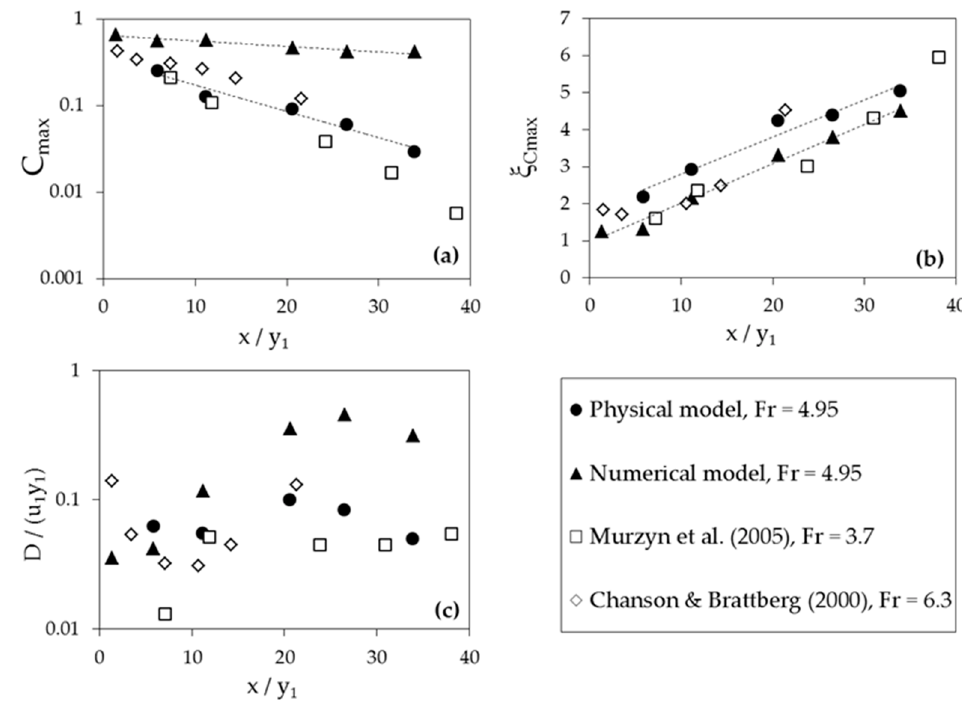
Figure7. Parametersofthevoidfractiondistributioninthehydraulicjump(lowerregion): ( a )Maximum Figure 7. Parameters of the void fraction distribution in the hydraulic jump (lower region): ( a ) void fraction ( C max ), ( b ) normalized height for the maximum void fraction ( ξ Cmax ), ( c ) di ff usion Maximum void fraction ( 𝐶 (cid:2923)(cid:2911)(cid:2934) ), ( b ) normalized height for the maximum void fraction ( 𝜉 (cid:3004)(cid:3040)(cid:3028)(cid:3051) ), ( c ) coe ffi cient ( D diffusion coefficient ( 𝐷 ).